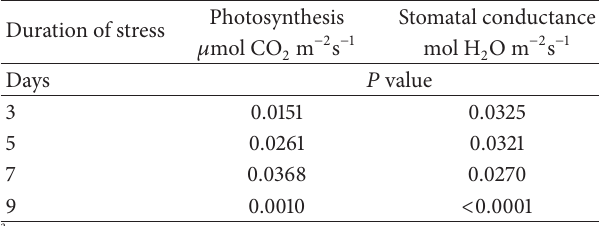
Table6: 𝑃 > 𝐹 forinfluenceofdroughtstressonphotosynthesisand stomatal conductance of an acetolactate synthase inhibitor-suscep- tible and glyphosate-susceptible Palmer amaranth accession a